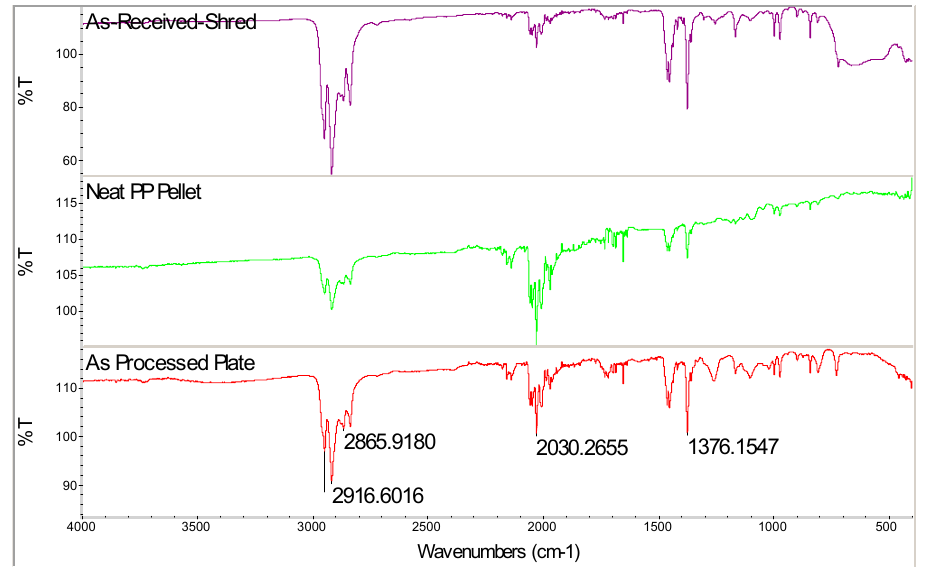
Figure 6. FTIR traces of the PP-GF shred, neat PP pellet and as-processed plate. There is no material degradation as evidenced by these tests.